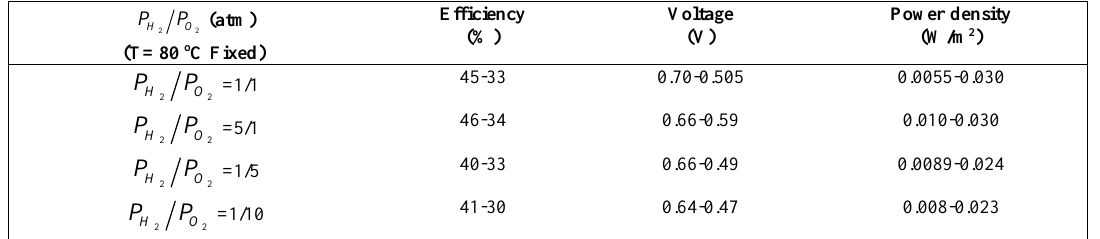
Table 4. Performance of single PEMFC at constant temperature and reactants flow pressure variation PP (atm) 22 HO (T= 80 o C